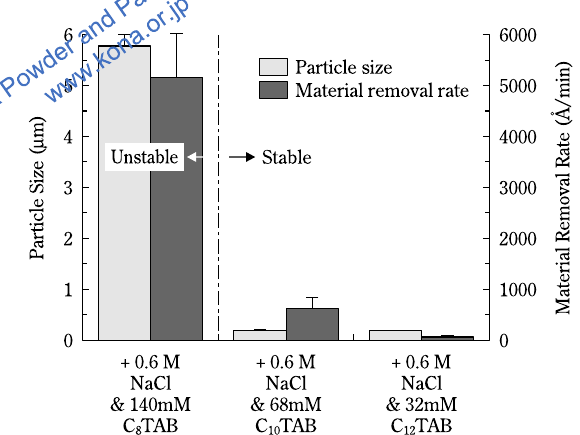
Fig. 3.2a: C 12 TAB, C 10 TAB, and C 8 TAB surfactants at 32, 68, and 140 mM concentrations in the presence of 0.6 M NaCl at pH 10.5: slurry particle size (stability) and material removal rate re- sponses (Reprinted from reference 27 with permission from Elsevier).